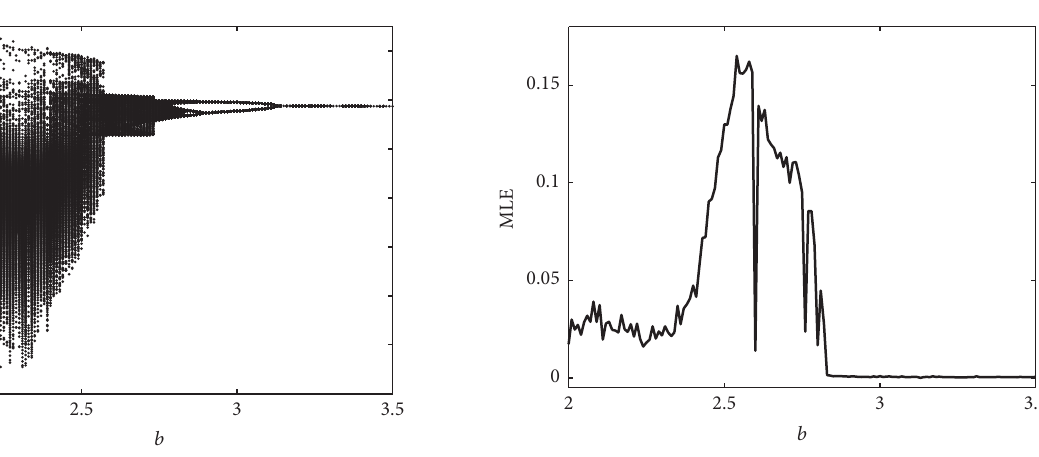
Figure 5: Maximal Lyapunov exponents of the system with closed curve equilibrium (9) in the range 2 ≤ 𝑏 ≤ 3.5 for 𝑎 = 4